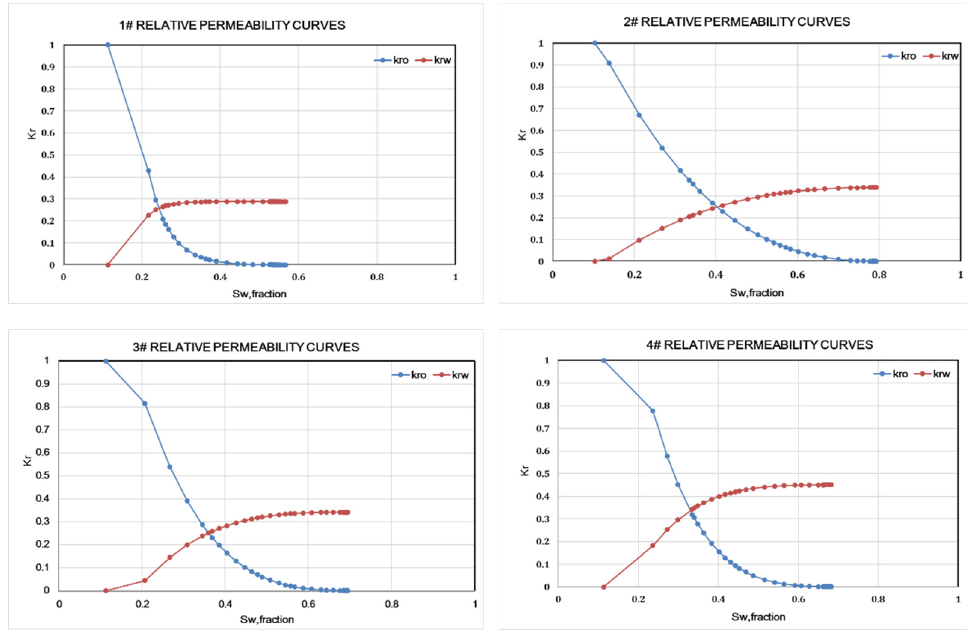
Table 4. Main parameters of core ‐ flooding experiments.